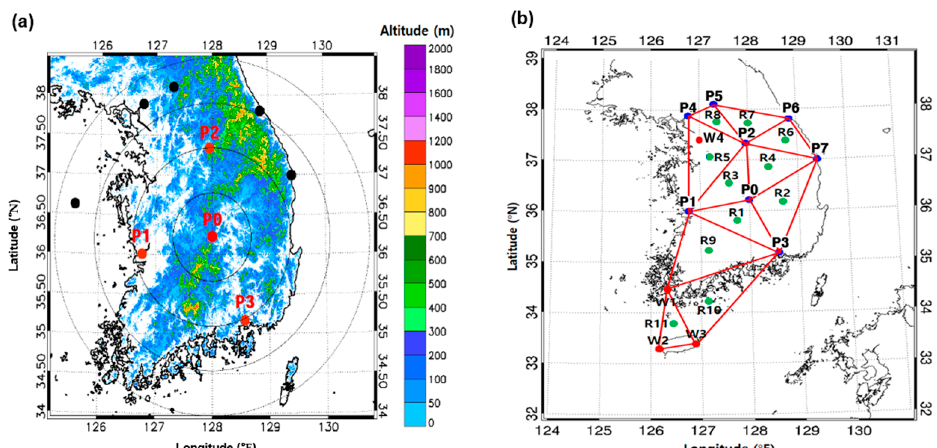
Figure 2. ( a ) positions of wind profilers at the P0, P1, P2, and P3 sites (red points) and the other five wind profilers (black points) superimposed on a topographical map of the South Korea peninsula. Here, 50-km intervals range circles are centered on P0, the profiler reference site. ( b ) a multiple-instrument network constructed by wind profilers (P1–P8) and S-band Doppler weather radars (W1–W4). Green points (R1–R11) indicate the center of the triangle from which the wind fields are derived. Table 1. Operational configuration of low- and high-mode strategies for the PCL 1300. Parameter Low Mode High Mode